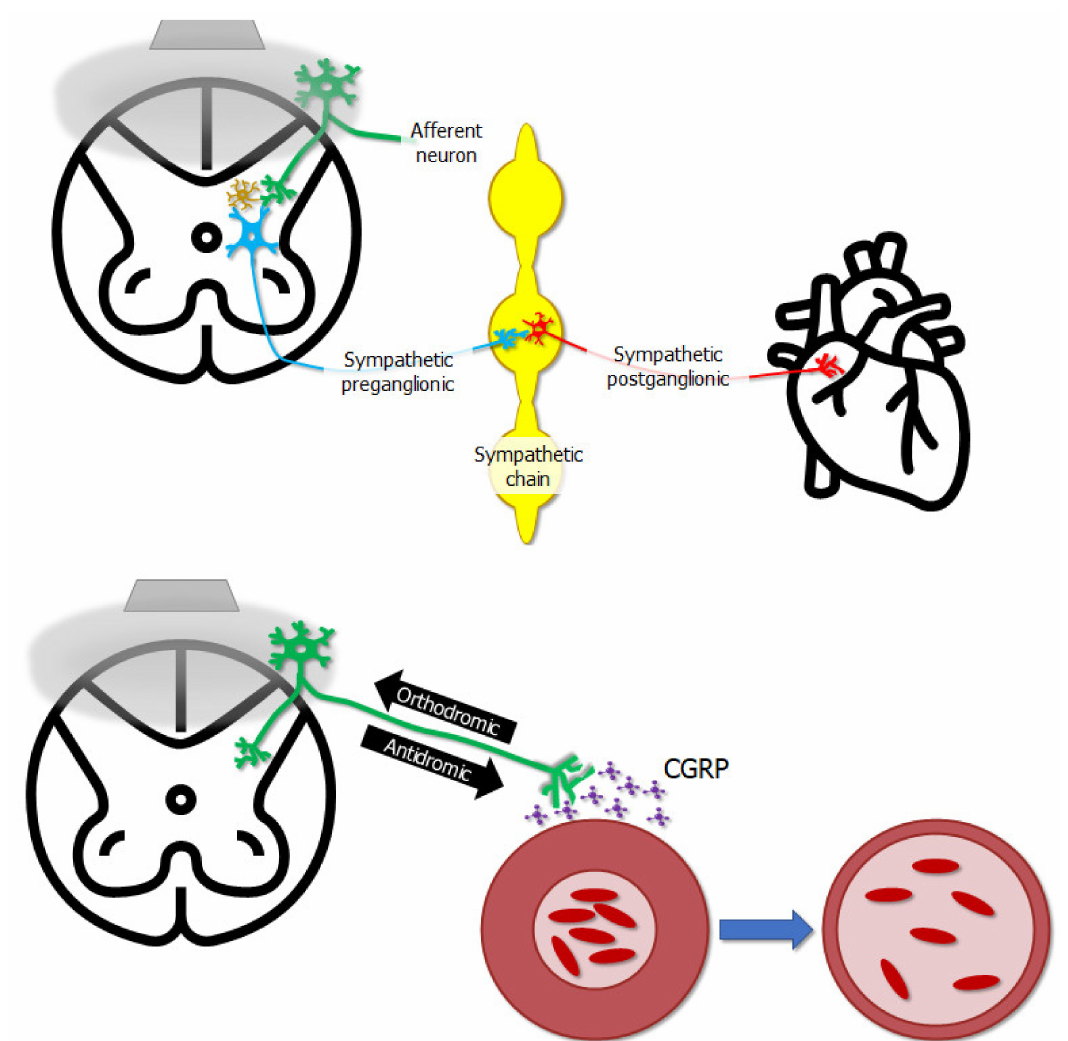
Figure 4. The gray trapezoid in the upper left represents a stimulator laying on the dorsal aspect of the spinal cord, and the gray bubble represents the electrical field emitted by the stimulator. The stimulator does not affect neurons innervating the heart directly—epidural stimulation affects the excitability of afferent neurons whose cell bodies lie in dorsal root ganglia on the dorsal aspect of the cord. These neurons in turn can affect the excitability of interneurons, represented by the gold neuron in the spinal cord, or afferent neurons can directly influence sympathetic preganglionic neurons. These in turn affect sympathetic post-ganglionic neurons, which finally innervate the heart, completing the chain of events by which epidural stimulation influences cardiac function. Electrical stimulation can potentially cause action potentials to